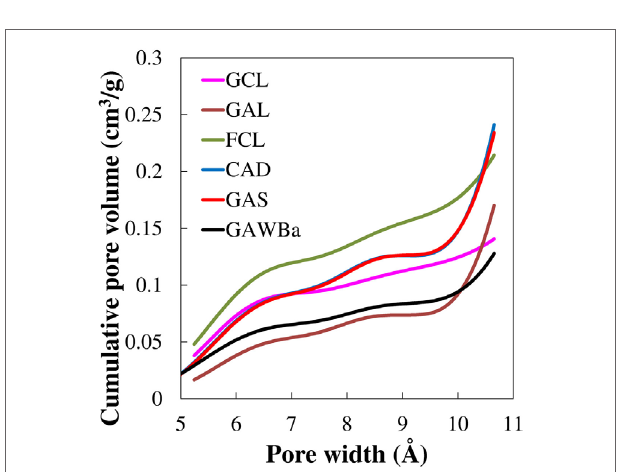
FigUre 7 | cumulative pore volume distributions from the cO 2 adsorption isotherms at 0°c